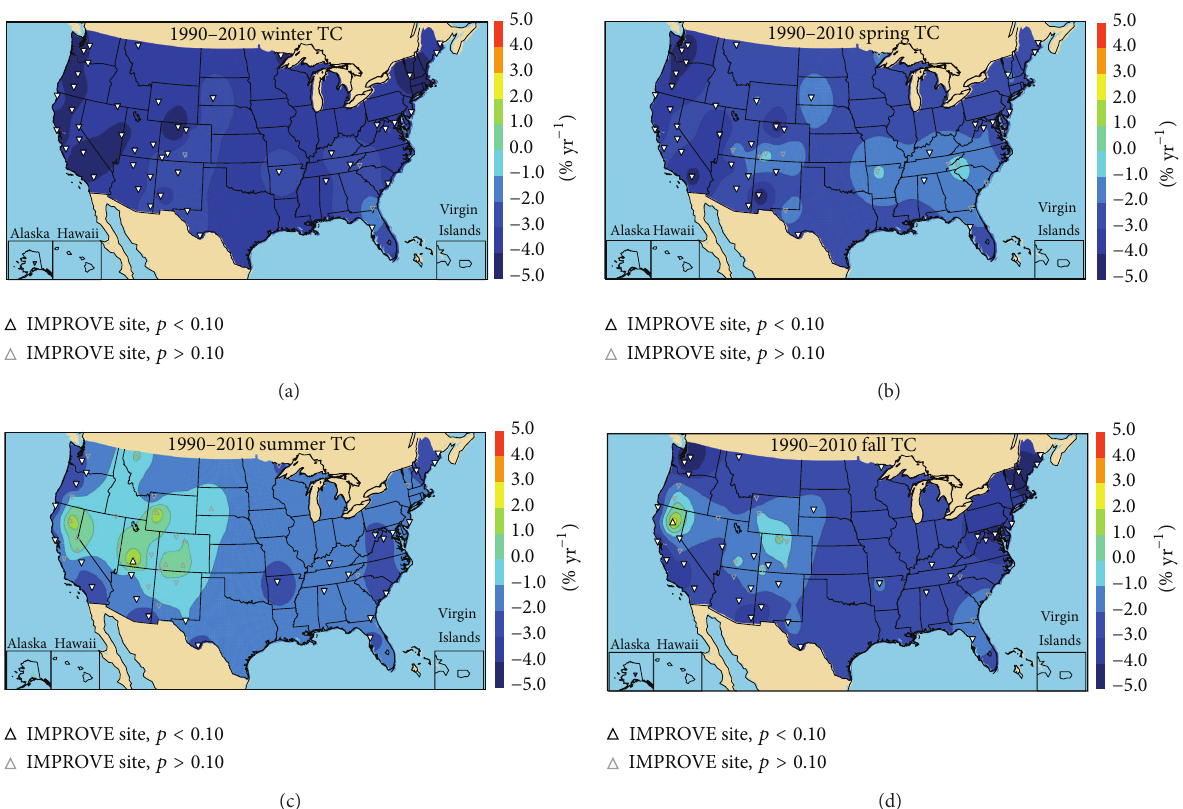
Figure 8: Long-term (1990–2010) trends (% yr −1 ) in IMPROVE seasonal mean PM 2.5 total carbon (TC = OC + EC) for (a) winter (DJF), (b) spring (MAM), (c) summer (JJA), and (d) fall (SON). White triangles correspond to IMPROVE sites. Upward pointing triangles correspond to increased concentrations and vice versa. Trends with significance levels ( p ) less than 0.10 were considered significant. (filled triangles). Unfilled triangles correspond to insignificant